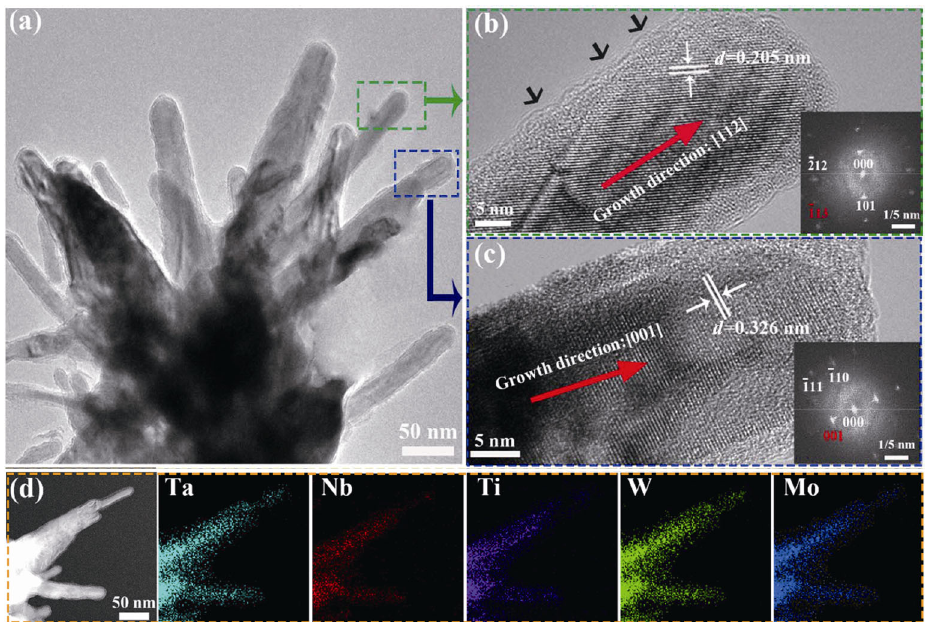
Fig. 4 TEM analyses of an individual HEB-1 nanoflower: (a) TEM image; (b) HRTEM image of the selected nanorod labeled by doted green square in (a); (c) HRTEM image of the selected nanorod labeled by doted blue square in (a); (d) STEM image and the corresponding EDS compositional maps. Table 2 Elemental atomic percentage of the as-syn- thesized HEB-1 nanoflowers by STEM  EDS analyses Element Ti